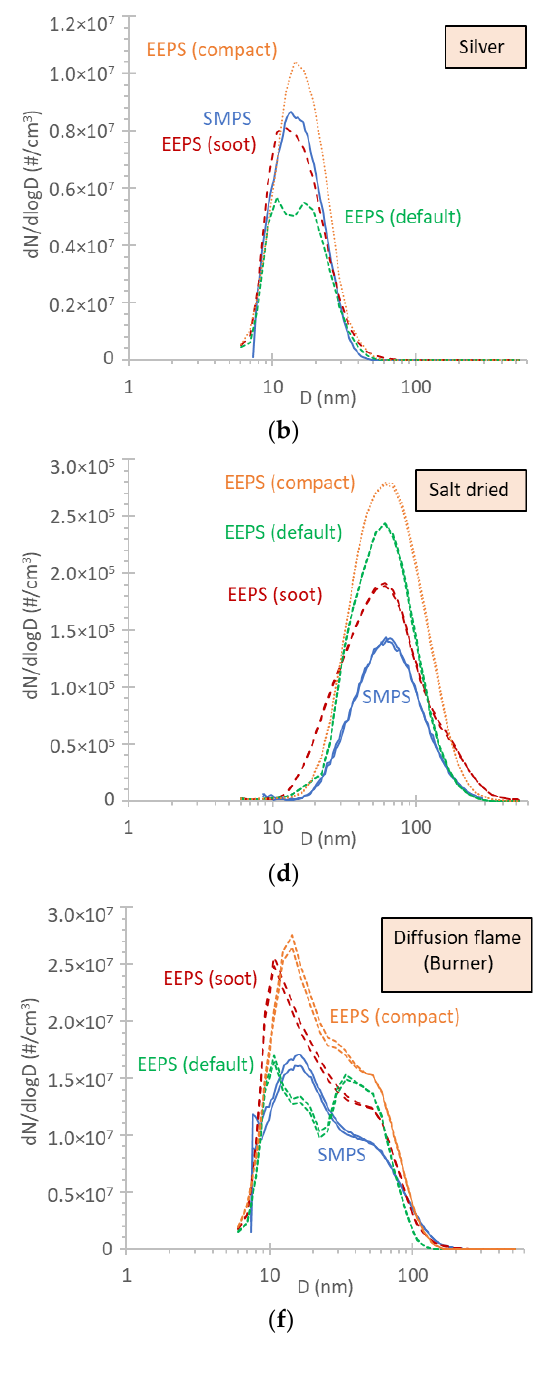
( j ) Figure A1. Size distributions measured with SMPS and EEPS applying the three matrices (“De- fault”, “Soot”, “Compact”): ( a ) GWG silver; ( b ) GWG silver; ( c ) SPG silver (oxidized); ( d ) salt (dried); ( e ) spark discharge graphite; ( f ) diffusion flame soot directly from the burner (setting 1); ( g ) diffu- sion flame soot directly from the VPR (setting 6); ( h ) diffusion flame soot directly from the VPR (setting 1); ( i ) diffusion flame soot directly from the VPR (setting 5); ( j ) diffusion flame soot directly from the VPR (setting 3). Settings can be found in Table 1. References 1.